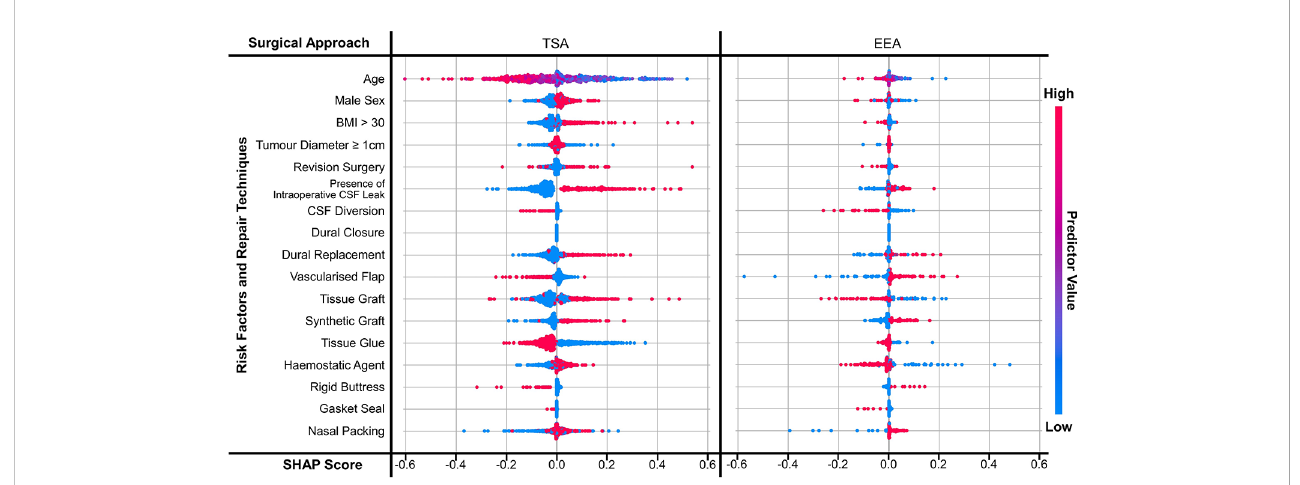
FIGURE 3 SHAP scores for predictors displayed as a bee diagram for the predictor category ‘ risk factors and repair techniques ’ , where the NNs are split by approach. Scores are shown for each predictor across all 5-folds. As shown in the ‘ predictor value ’ legend – a high value is indicated in red, and a low value is indicated by blue; for binary variables this means red indicates a value of 1 (i.e. present) and blue indicates a value of 0 (i.e. not